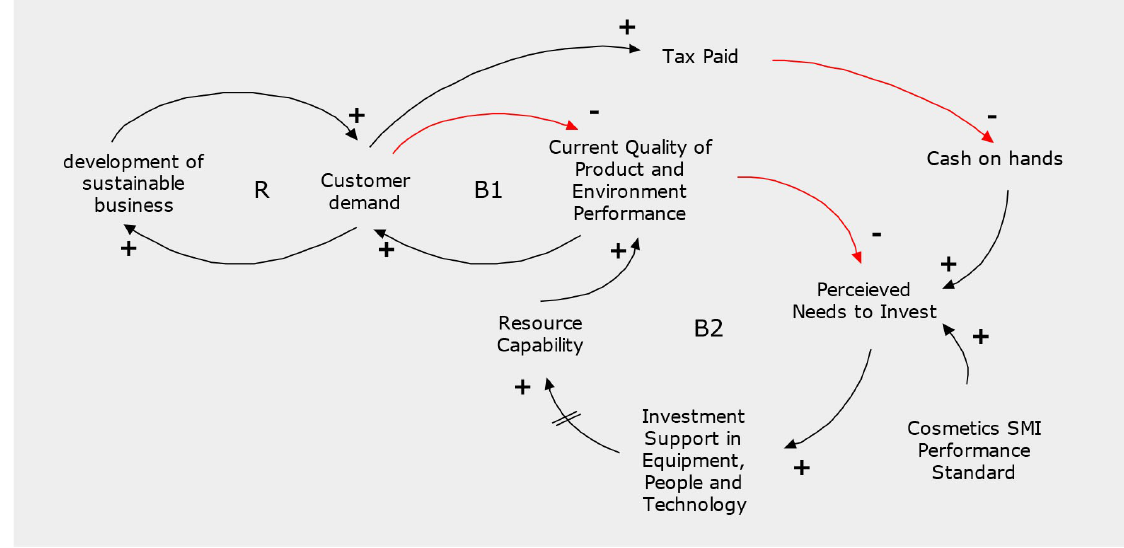
Figure 6. CLD of SMI’s growth and under-investment archetype